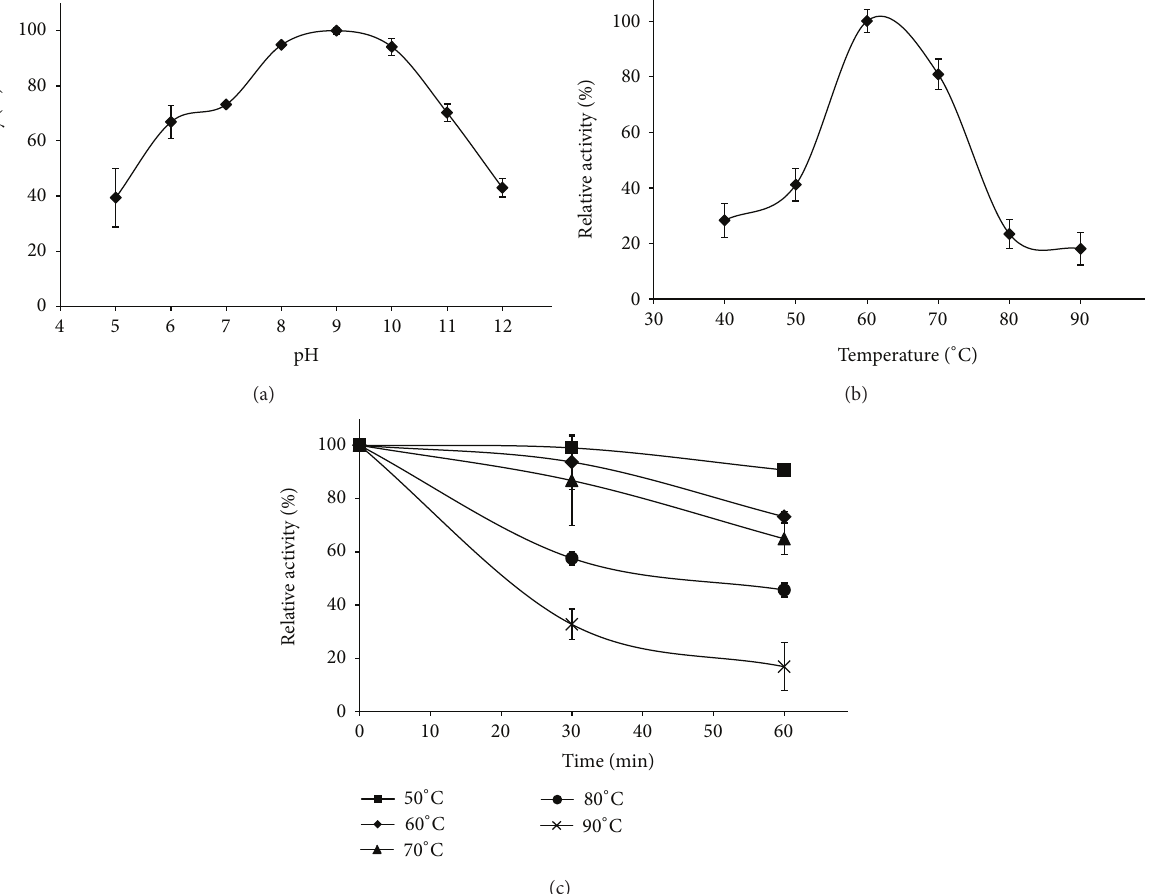
Figure 3: Effect of pH and temperature on activity. (a) Activity of protease at various pH and 60 ∘ C. (b) Activity of protease at various temperatures and pH 9. (c) Activity of protease after heat treatment. Residual activity was assayed at 60 ∘ C and pH